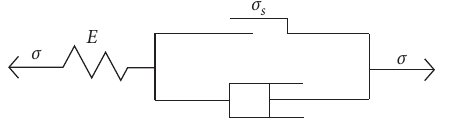
Figure 1: Conventional Bingham